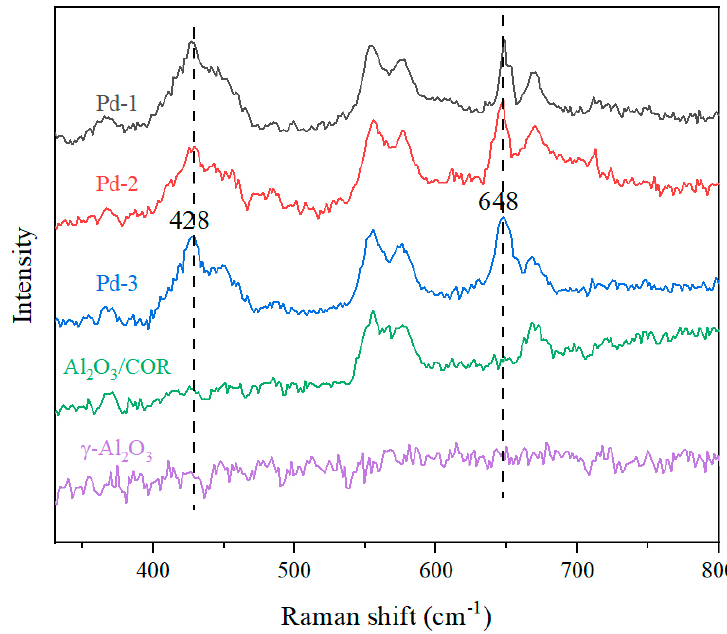
Figure 4. Raman spectra of Pd-1, Pd-2, Pd-3, Al 2 O 3 /COR and Al 2 O 3 .